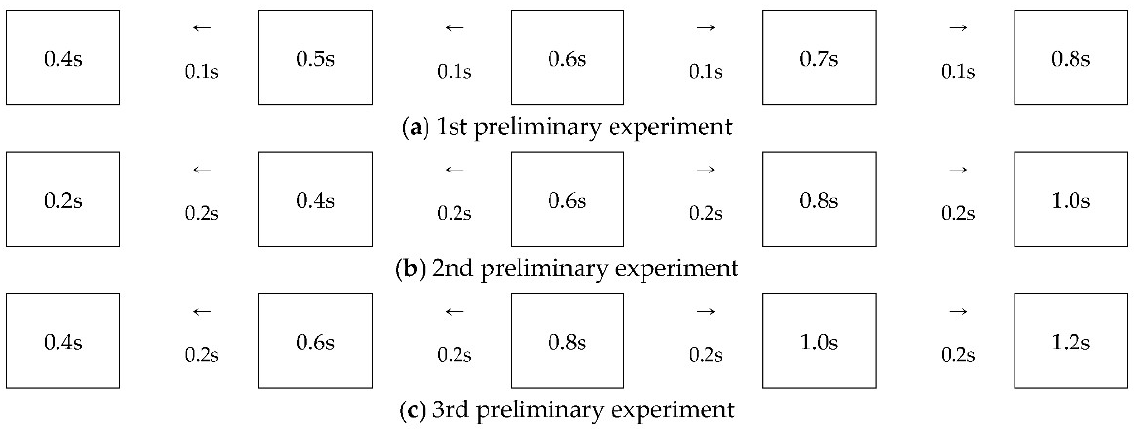
Figure 7. Preliminary experiment results.